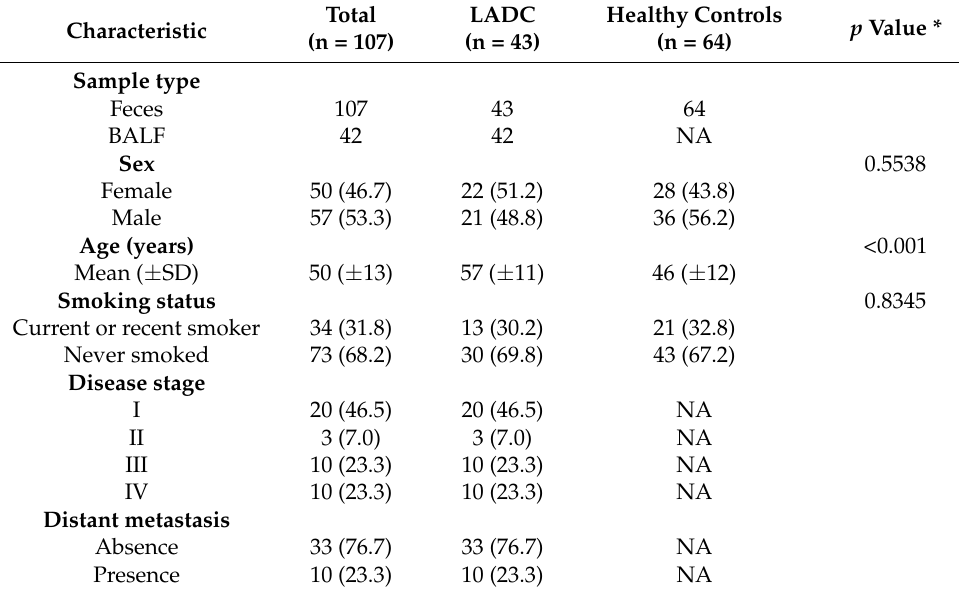
Table 1. Clinical characteristics of patients with LADC and healthy